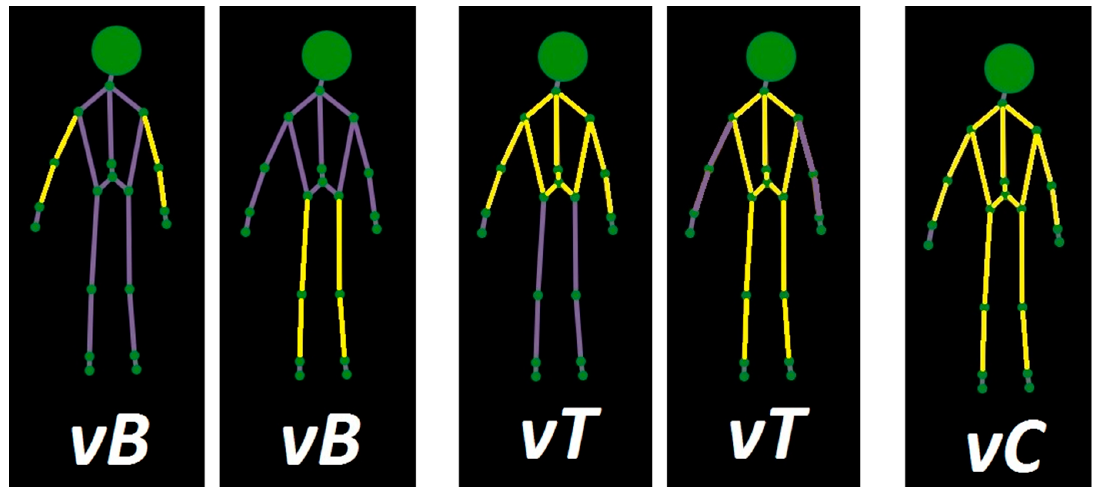
Figure 1. Visual representation of the sets vB, vT and vC.